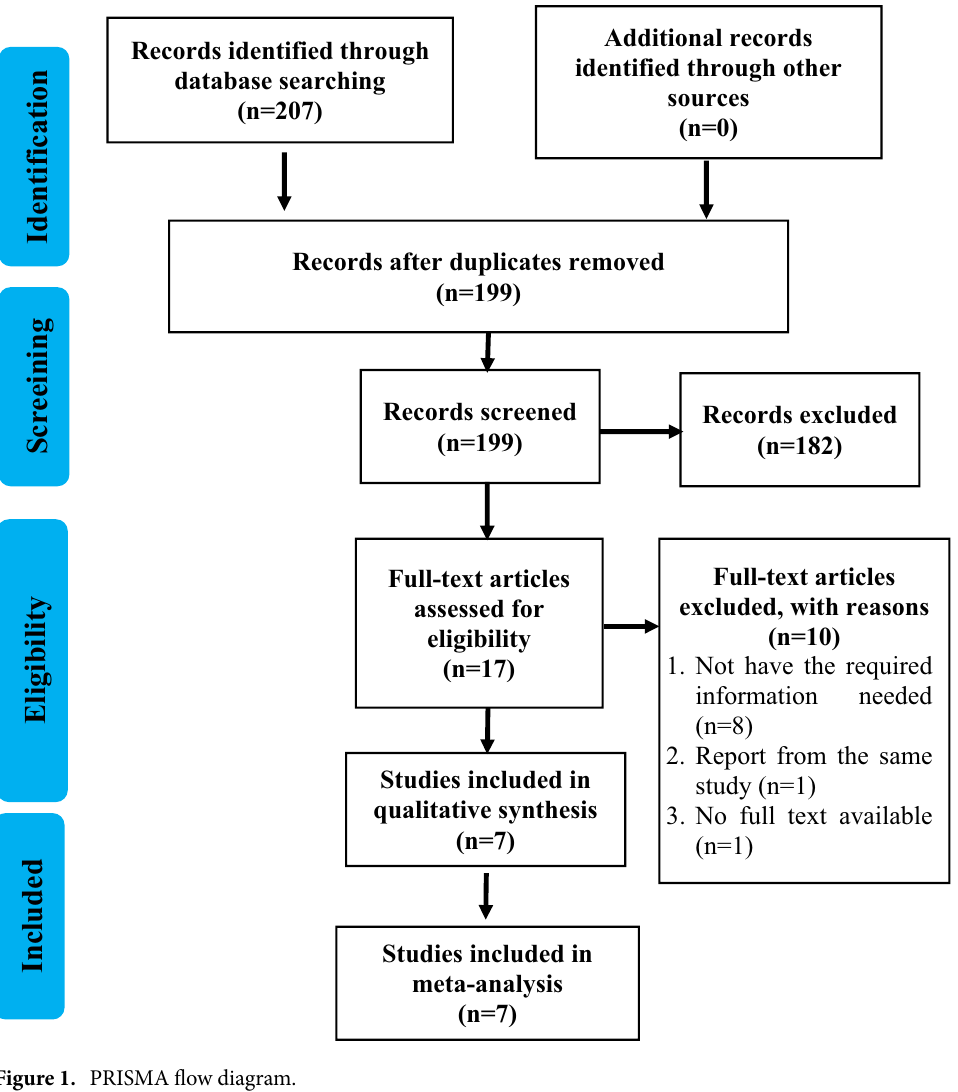
Figure 1. PRISMA flow